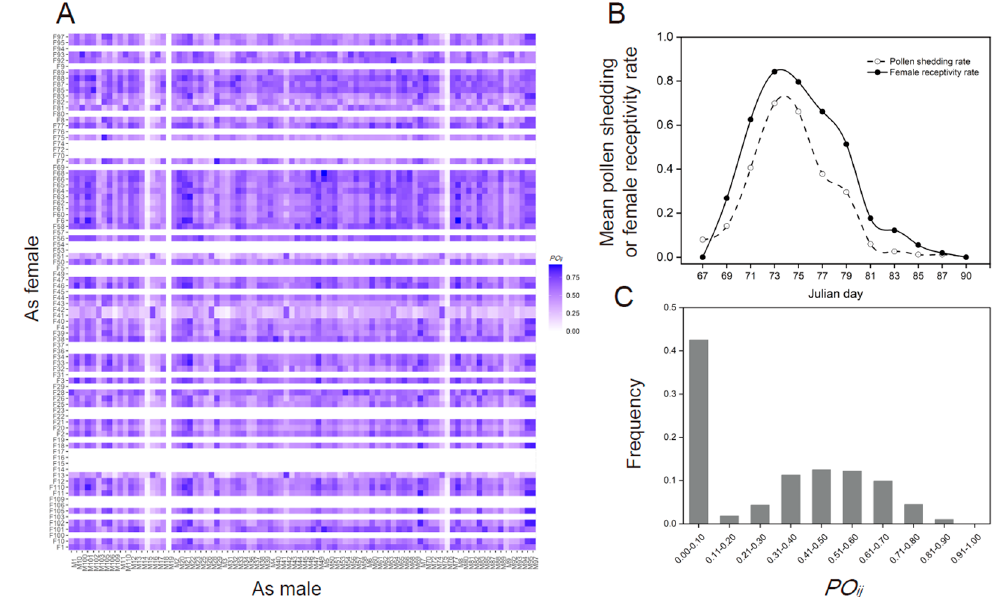
Figure 4. Variation in phenological synchronization of clones/individuals in seed orchard. Note: PO ij is the phenological synchronization index of individuals. ( A ) Phenological synchronization among individuals. ( B ) Periods of pollen shedding and female receptivity in the seed orchard. ( C ) Distribution of phenology synchronization index values of all individuals.